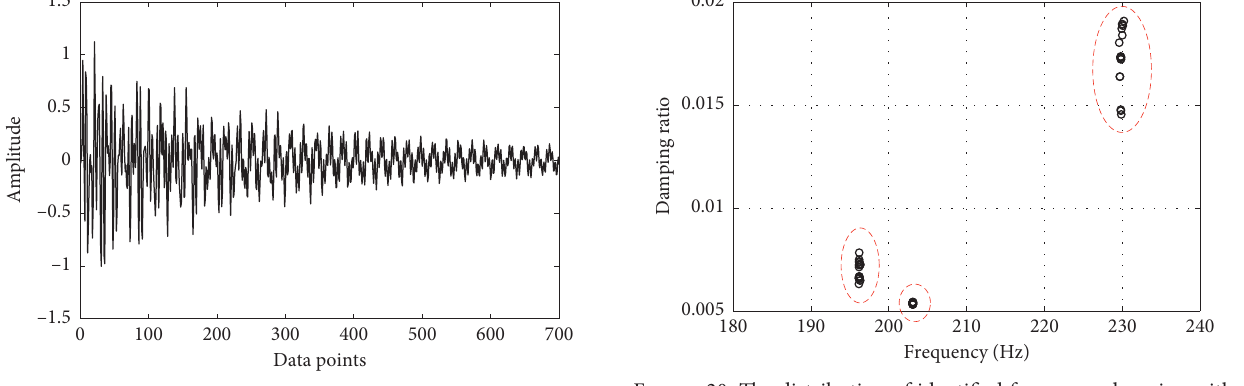
Figure 18: Estimated impulse response for cargo bolts under random excitation in damage case ① .